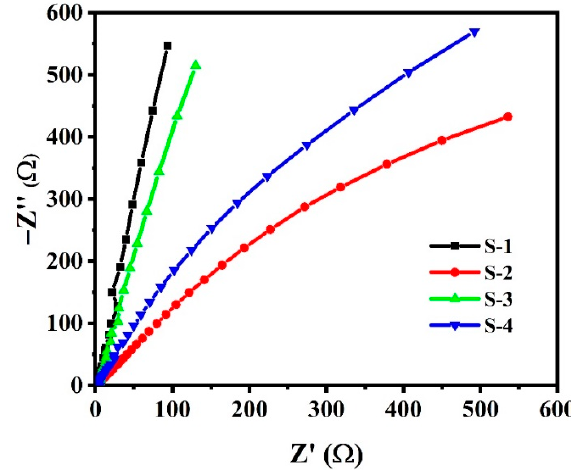
Figure 5. Nyquist plots of samples S-1 to S-4.